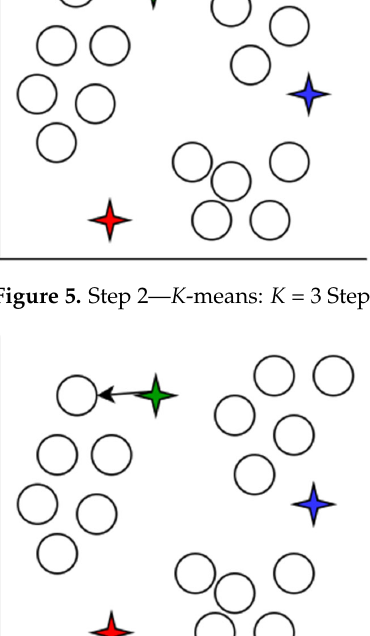
(cid:113) ∑ n − x ( y ) 2 Euclidean i i i = 1